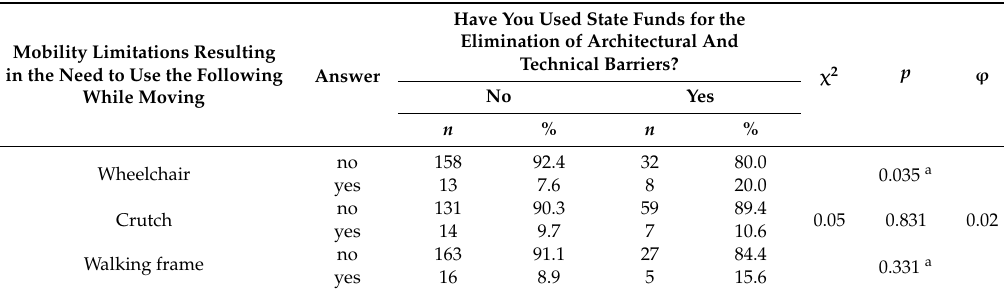
Table 2. Mobility limitations